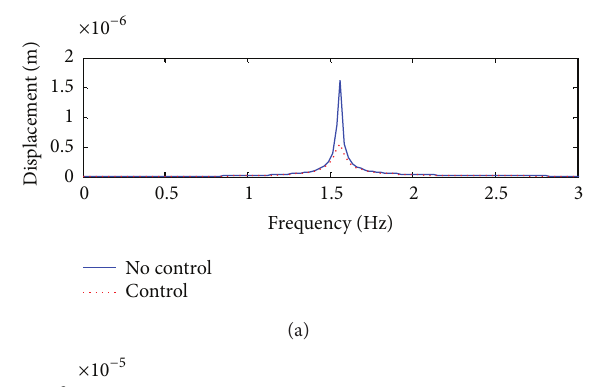
Figure 9: Control results of velocity.